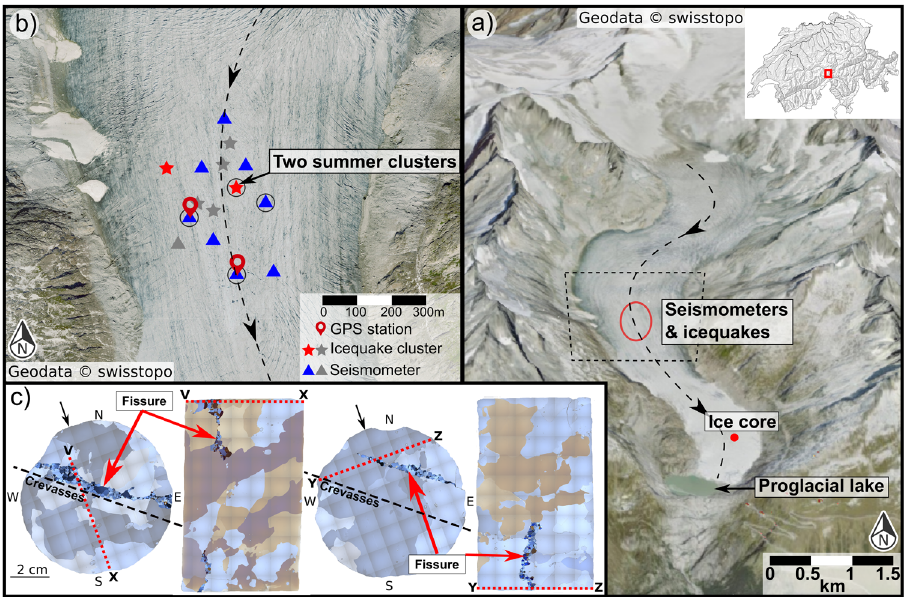
Fig. 1 Study site on Rhonegletscher showing fi eld instrumentation and thin sections of ice core samples. a Overview of study site on Rhonegletscher with its location in Switzerland shown in inset map, dashed box outlines the area shown in ( b ), dashed black line approximates the central fl ow line. The scale bar applies to the bottom of the dashed box (due to the 3D effect). b Locations of basal stick-slip icequake clusters (red stars) and seismometers (blue triangles) active/operational during summer used in this study. Grey coloured items indicate the positions of remaining summer clusters/ seismometers that were discarded due to low-quality data or poor temporal coverage. Ruby pins indicate differential GPS stations. Circled blue triangles indicate seismometers that were operational also during winter. Circled red star denotes locations of three nearly co-located through different stick-slip clusters: one active only during winter and two active during summer. The dashed black line approximates the central fl ow line. c Thin section of the ice core (images obtained from cross-polarized light microscopy, the location shown in ( a )) with different colours depicting crystals with different c-axis orientations. The two examples at 45 m depth show fi ssures with small crystals (shown in dark blue) grown during refreezing upon core extraction. Red dotted lines indicate the mutual orientation of vertical (rectangular) and horizontal (circular) cuts. The ice fl ow direction is shown with black arrows. In both examples, the orientation of the fi ssures is 45° with respect to glacier fl ow and thus aligned with the nearby crevasses (marked with black dashed lines). Source of a , b base maps: Swiss Federal Of fi ce of